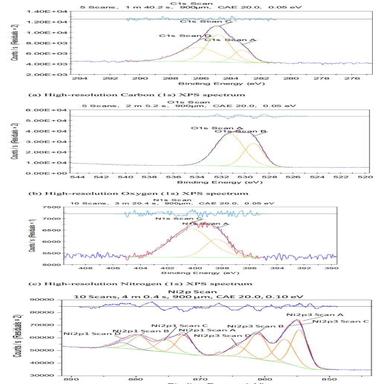
(a) High-resolution Carbon (1 s) XPS spectrum; (b) High-resolution Oxygen (1 s) XPS spectrum; (c) High-resolution Nitrogen (1 s) XPS spectrum; (d) High resolution Nickel (2p) XPS spectrum with 2p3 and 2p1.